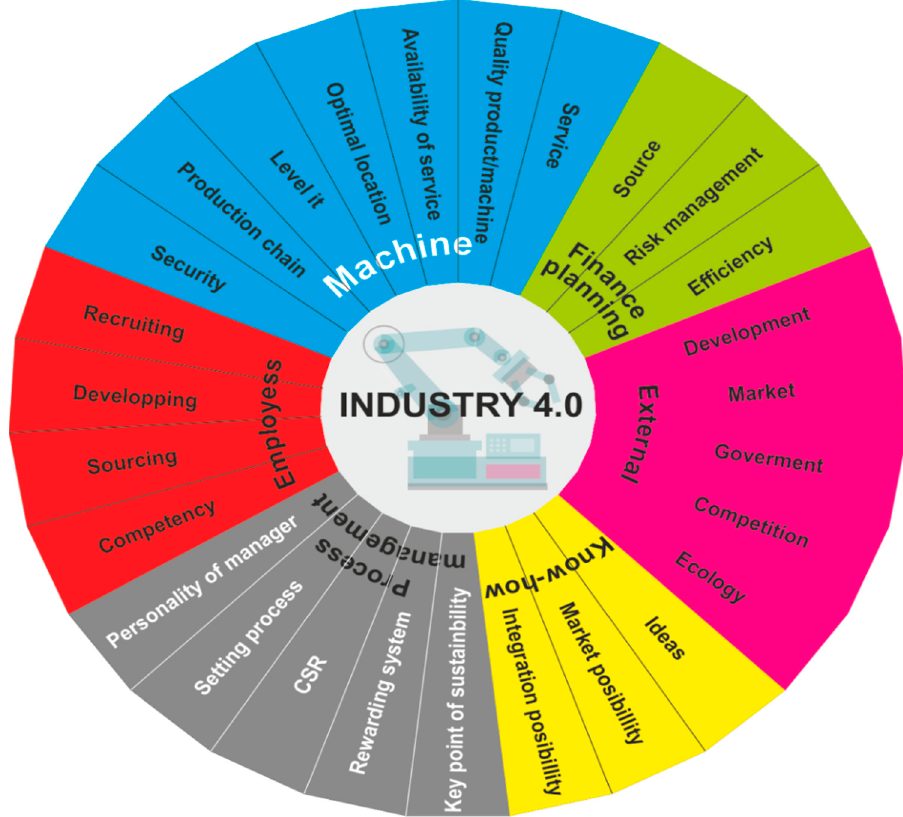
Figure 1. Factors influencing the introduction of Industry 4.0 elements in small and medium-sized enterprises (SMEs).